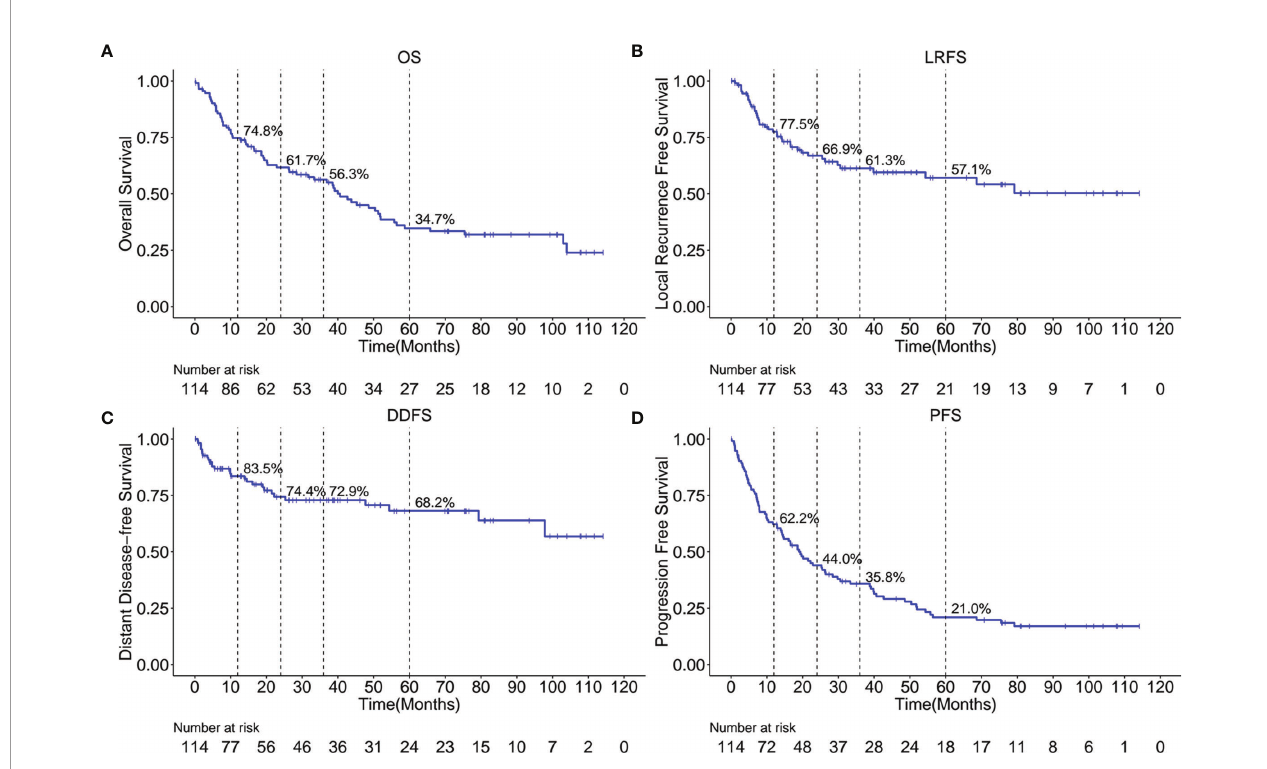
FIGURE 1 | Kaplan-Meier curves showing OS (A) , LRFS (B) , DDFS (C) and PFS (D) over time for the entire cohort. OS, overall survival; LRFS, local recurrence free survival; DDFS, distant disease-free survival; PFS, progression free